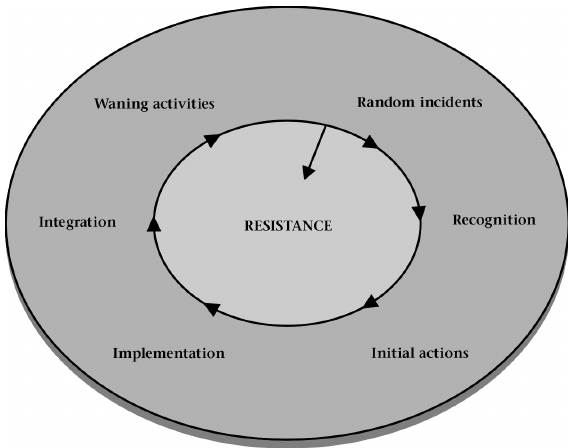
Figure 2: Cycle of change (Maurer, 1996, p.